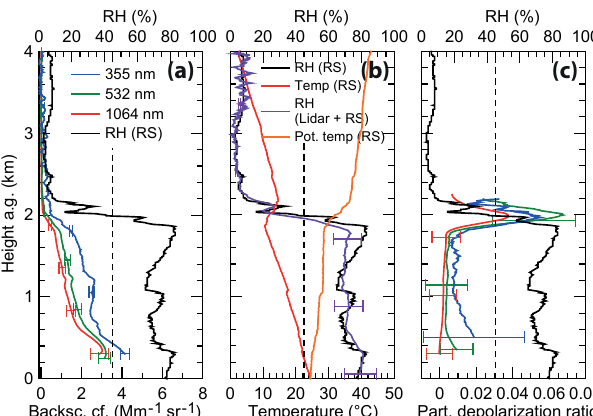
Figure 10. Same as Figure 9 but for 24 February 2014, 18:12–20:20 local time (22:12–00:20UTC). In panel (b) , the respective 2h RH profile (from lidar) is shown together with the radiosonde profiles (launch at 23:07UTC). The MAL was entirely humid on this